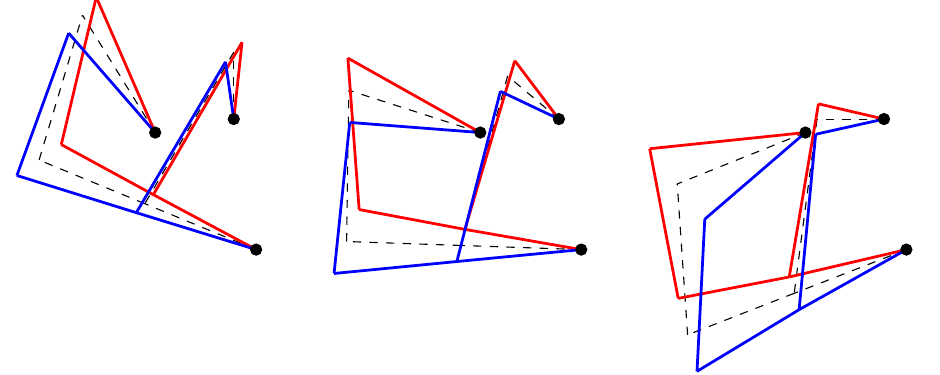
Figure 8. Mode 2 in three different configurations. ( Left ) α 3 = 90 ◦ . ( Middle ) α 3 = 140 ◦ . ( Right ) α 3 = 180 ◦ . ( ) Undeformed model; ( ) extreme deformed configurations during oscillation.